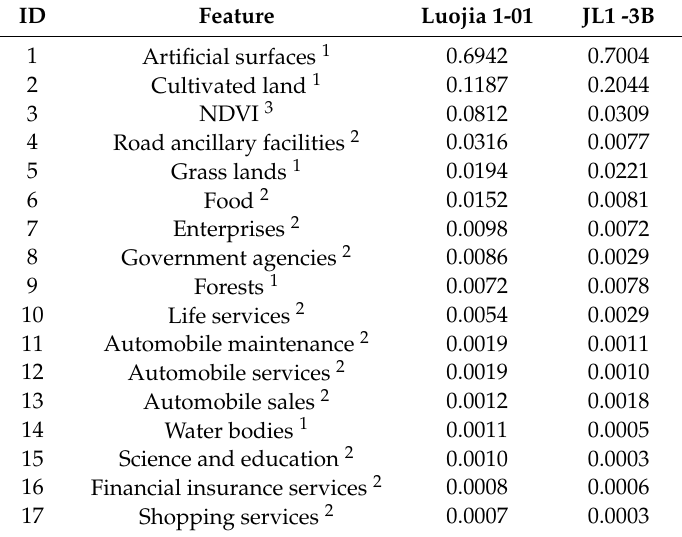
Table 4. The Gini of di ff erent features importance ( 1 : from land use, 2 : from POI, 3 : from NDVI). ID